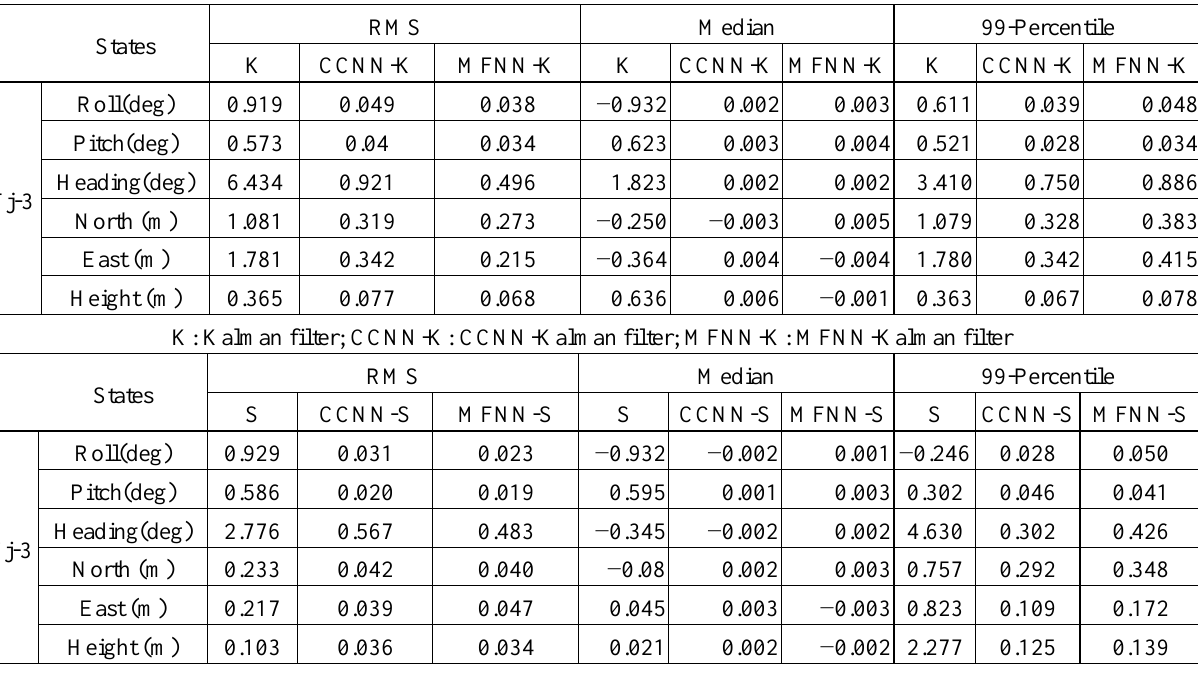
Table 3. Statistical Summary of the compensated positional and orientation solutions (Training